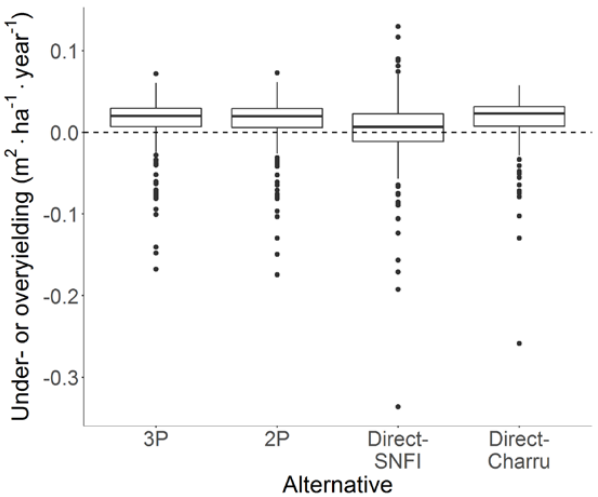
Figure 7. Boxplots of predicted under- or over-yielding for 50%–50% proportions on the 192 NFI mixed sites using different alternatives to define the species proportion (3P, 2P, Direct-SNFI, and Direct-Charru). 3P: 3-parameter extended competition density rule; 2P: 2-parameter extended competition density rule; Direct-SNFI: BA max is calculated directly using STR coefficients derived with SNFI data; Direct-Charru: BA max is calculated directly using STR coefficients by Charru et al.